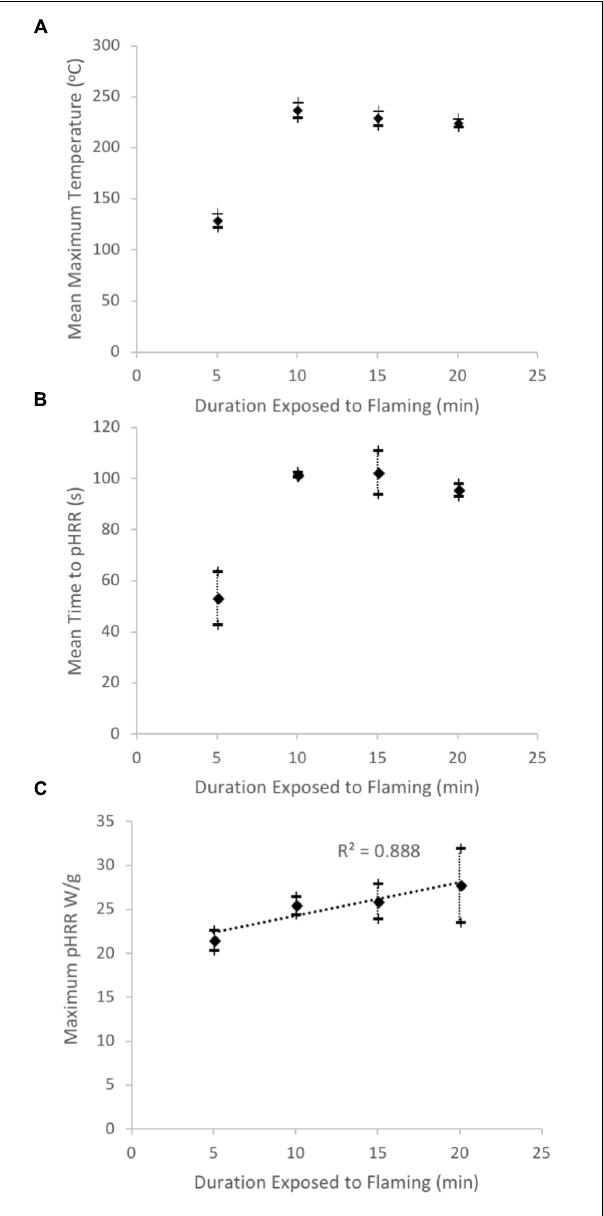
FIGURE 8 | Thermal reactivity of chars as measured in the microcalorimeter showing results from the analysis of four sets of charcoal formed during flaming combustion in the iCone calorimeter for 5, 10, 15, and 20 min. (A) The mean temperature at which the charcoals reached their maximum rate of decomposition during re-heating in the microcalorimeter. (B) The mean time taken for the charcoals to reach peak heat release rate (pHRR) in the microcalorimeter and (C) shows a strong positive relationship between the duration of heating over which the samples were originally formed in the iCone calorimeter and the maximum pHRR attained on re-heating in the